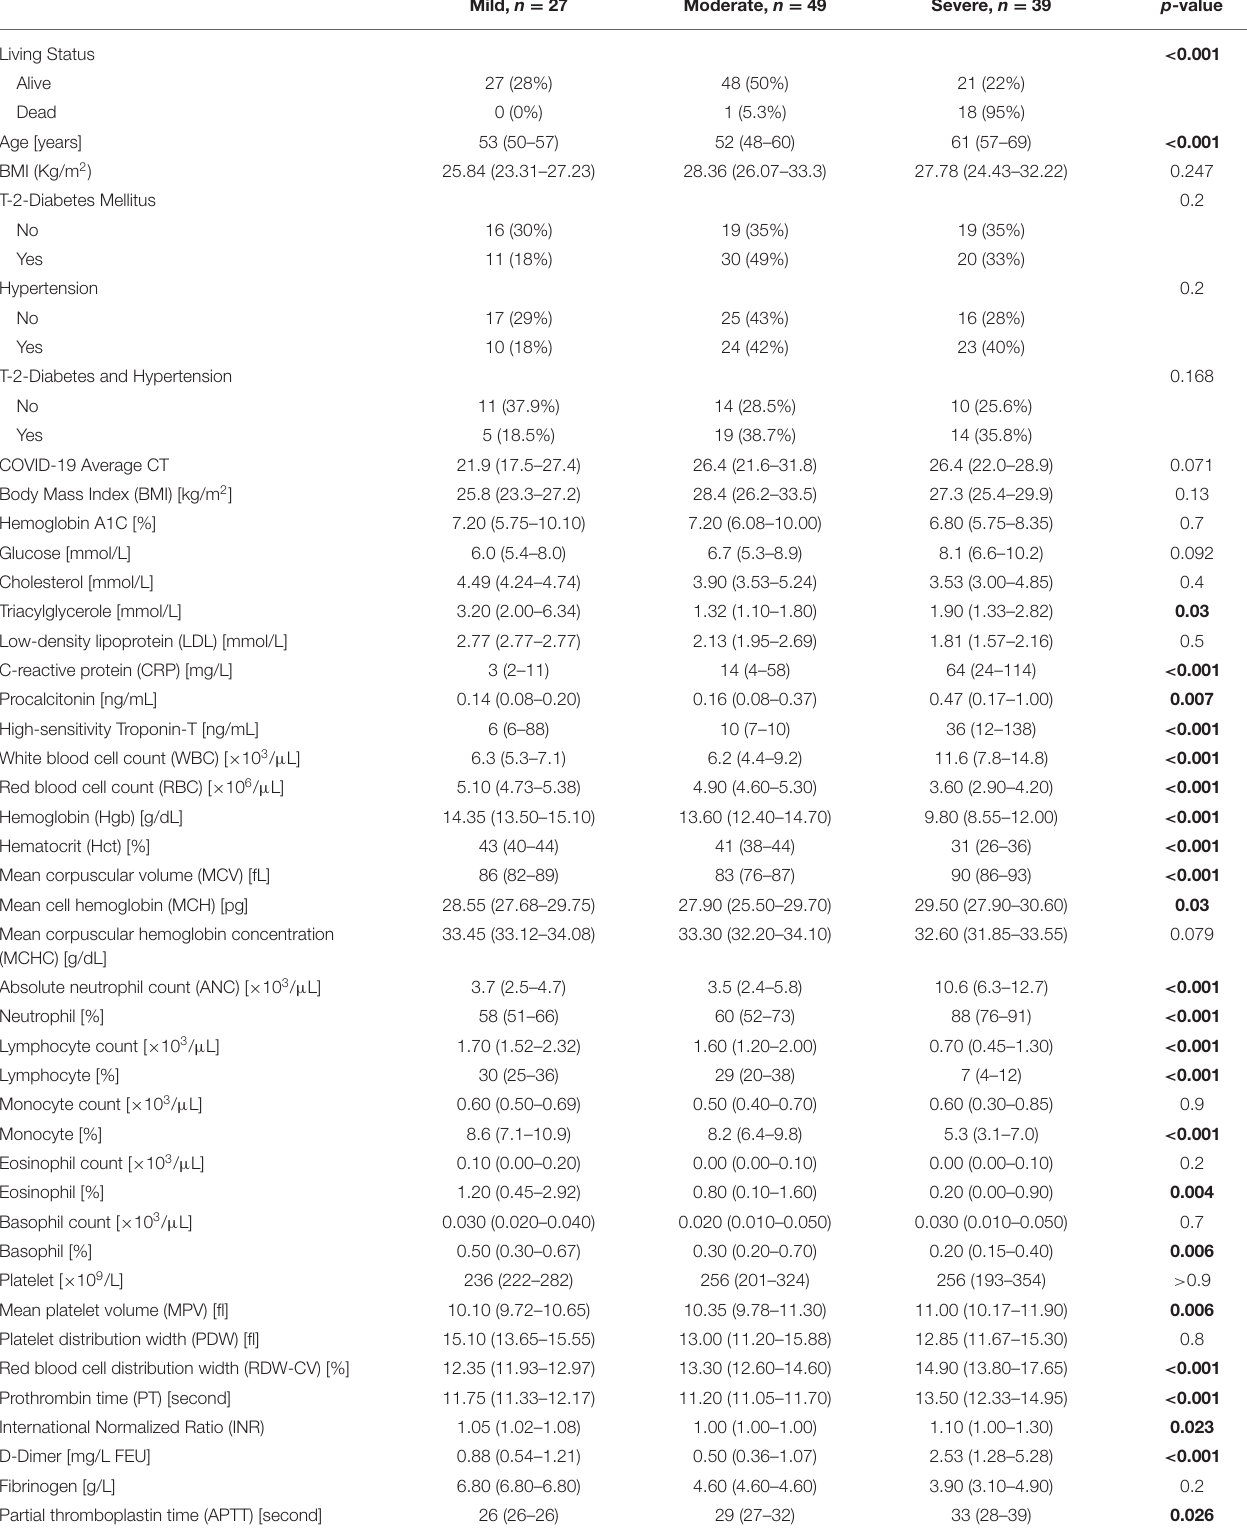
TABLE 1 | Demographic characteristics and clinical laboratory values of COVID-19 patients by disease severity. Mild, n = 27 Moderate, n = 49 Severe, n = 39 p